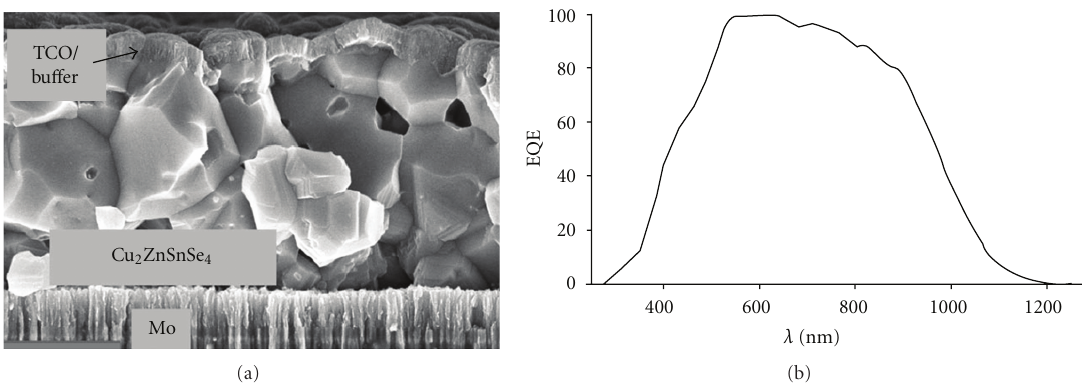
Figure 6: SEM of cross section and EQE of thin film solar cells based on CZTSSe light absorber (taken from [11]).